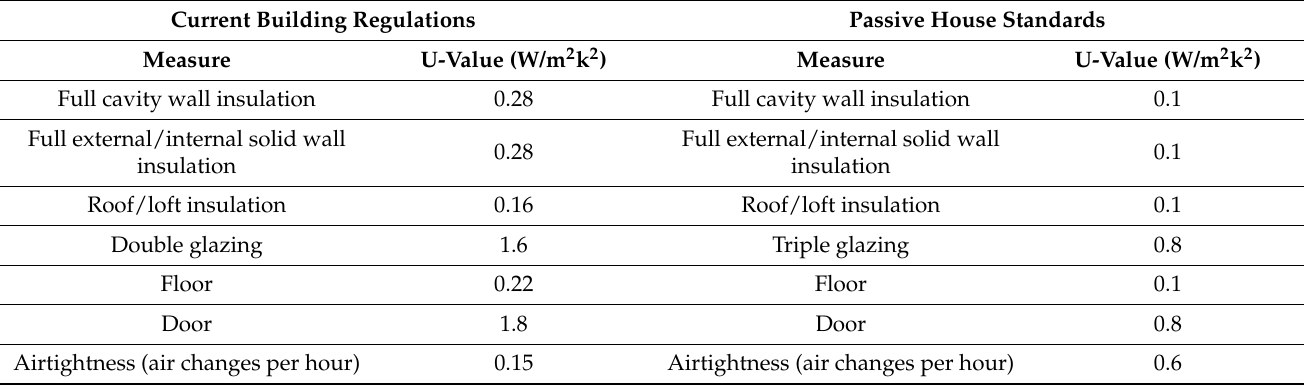
Table 3. Comparison between standard thermal guidelines for retrofit and proposed ultra-high/ passive house standards for new builds.